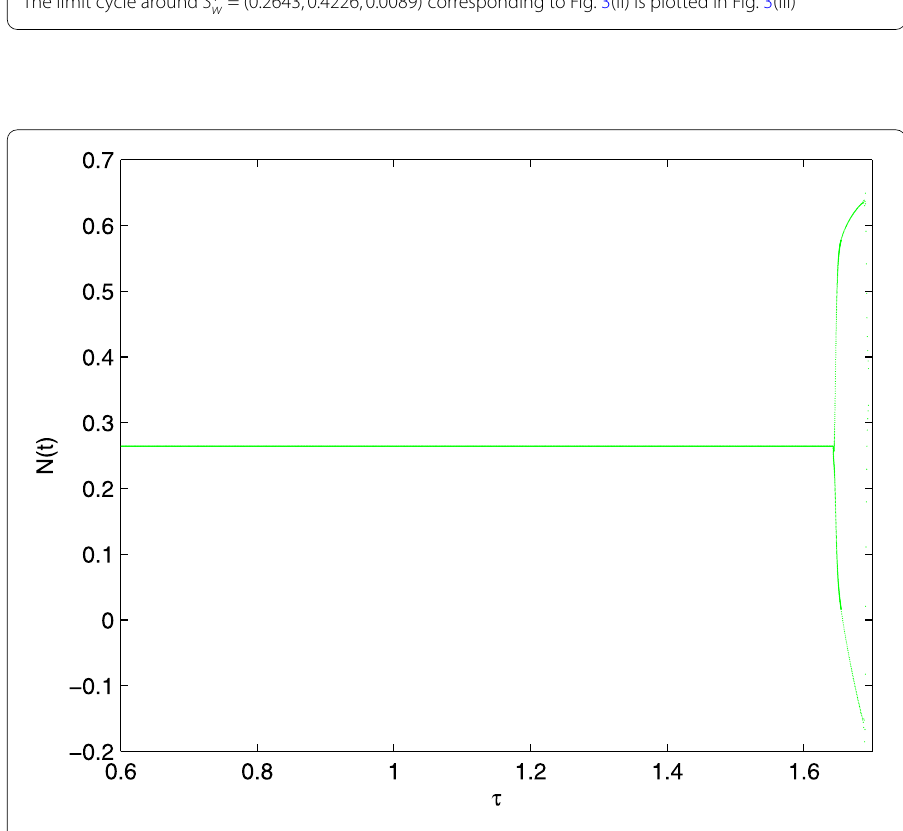
Figure 3 In the case of weak Allee effect, dynamical variations of prey, predator biomass, and harvest amount with the increasing time with τ = 0.8 and τ = 1.6429, which are indicated in Fig. 3(i) and Fig. 3(ii), respectively. The limit cycle around ˜ S ∗ w = (0.2643,0.4226,0.0089) corresponding to Fig. 3(ii) is plotted in Fig. 3(iii)